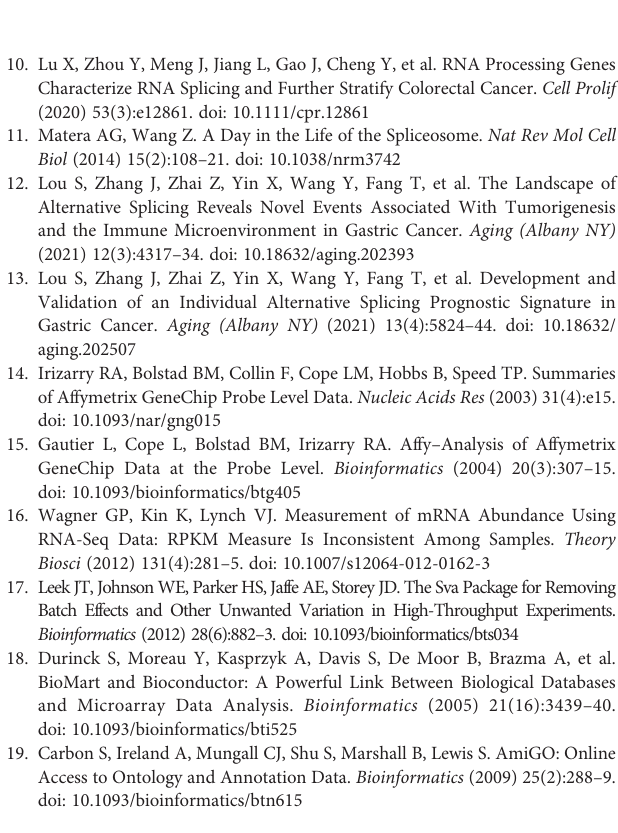
Supplementary Table 1 | 929 genes, annotated as RNA processing factors, acquired in the AmiGO database. Supplementary Table 2 | 819 RNA processing factors involved in all data sets. Supplementary Table 3 | 105 OS associated RNA processing factors. Supplementary Table 4 | Difference of GSVA scores between the high-risk and low-risk groups. Supplementary Table 5 | 358 differentially expressed ASEs and 28 differentially expressed RNA processing genes. Supplementary Table 6 | GO analysis was performed for all differentially spliced genes. Supplementary Table 7 |